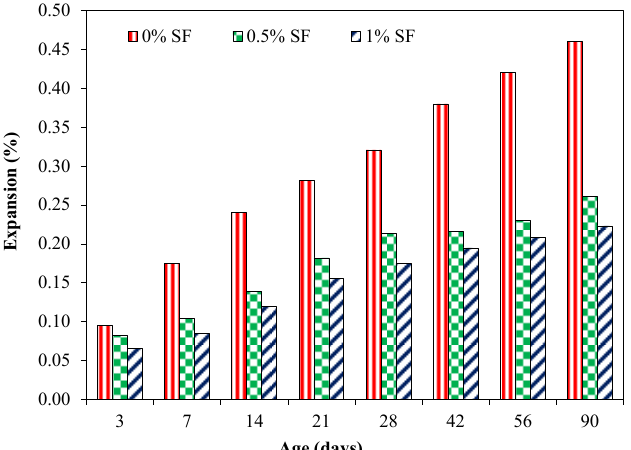
Figure 12. Expansion results for specimens incorporating steel fibers exposed to ASR conditions.